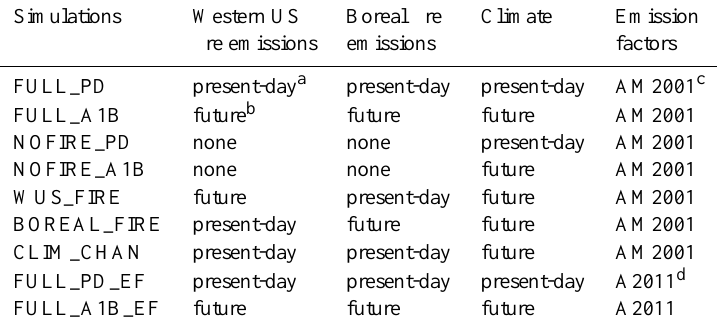
Table 1. Summary of simulations in this study. Simulations Western US